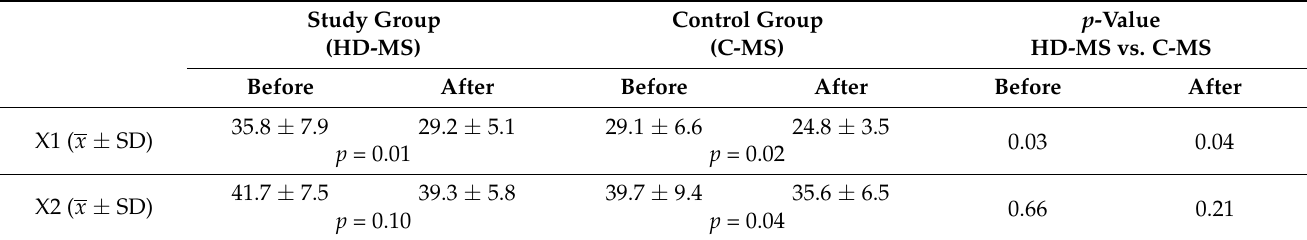
Table 4. Effect of rehabilitation program on the studied parameters in the study (HD) and control group (C) with metabolic syndrome (MS).